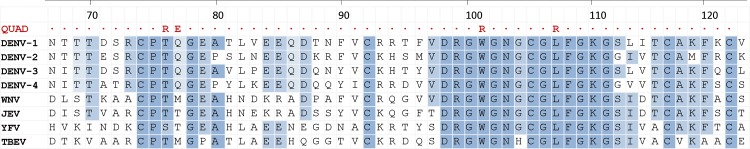
Alignment of the amino acid sequences containing the fusion loop domain from E proteins of DENV 1–4, WNV, JEV, YFV, TBEV and the four point mutations of the QUAD proteins.Amino acids numbering: 1 is start of the E protein.